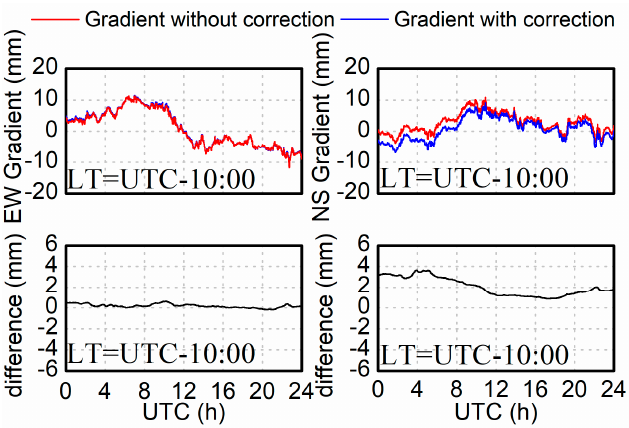
Figure 11. The estimated tropospheric horizontal gradients ( top ) with and without HOI corrections and their differences ( bottom ) on station MAUI during the quiet period.